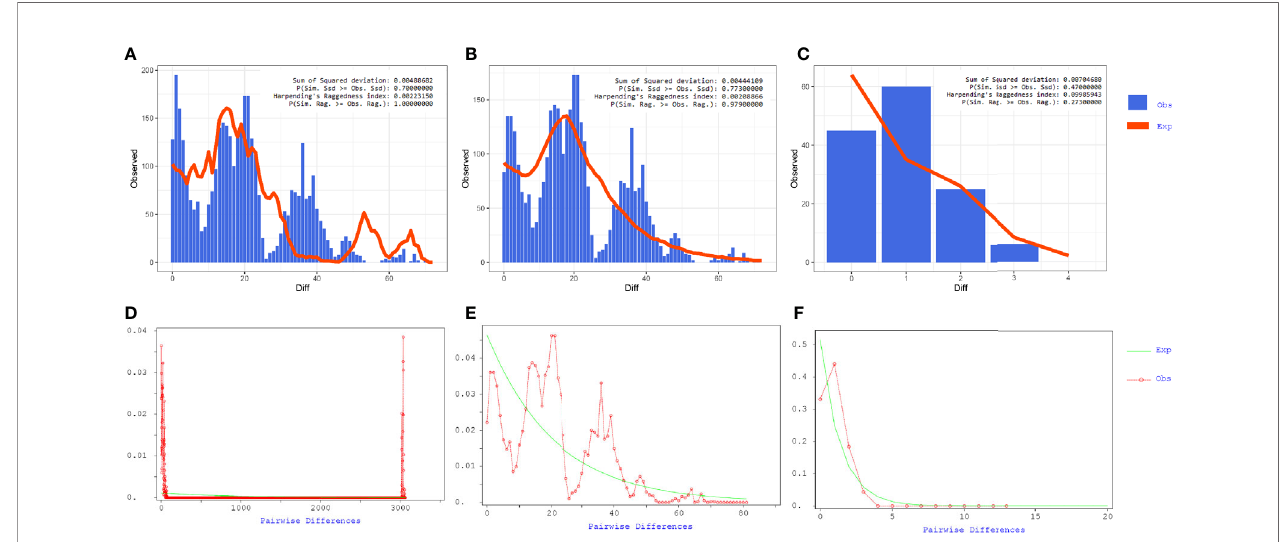
FIGURE 7 | Mismatch distribution analyses of coding region alignment of 105 genomes from Shunde hospital. (A – C) Results of Mismatch distribution analyses by Alrequin. (D – F) Results of Mismatch distribution analyses by